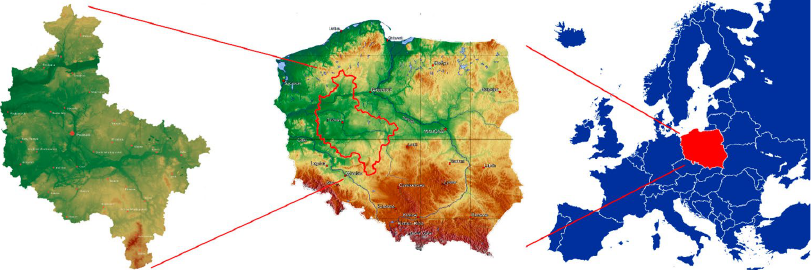
Figure 1. The Wielkopolska region in Poland and